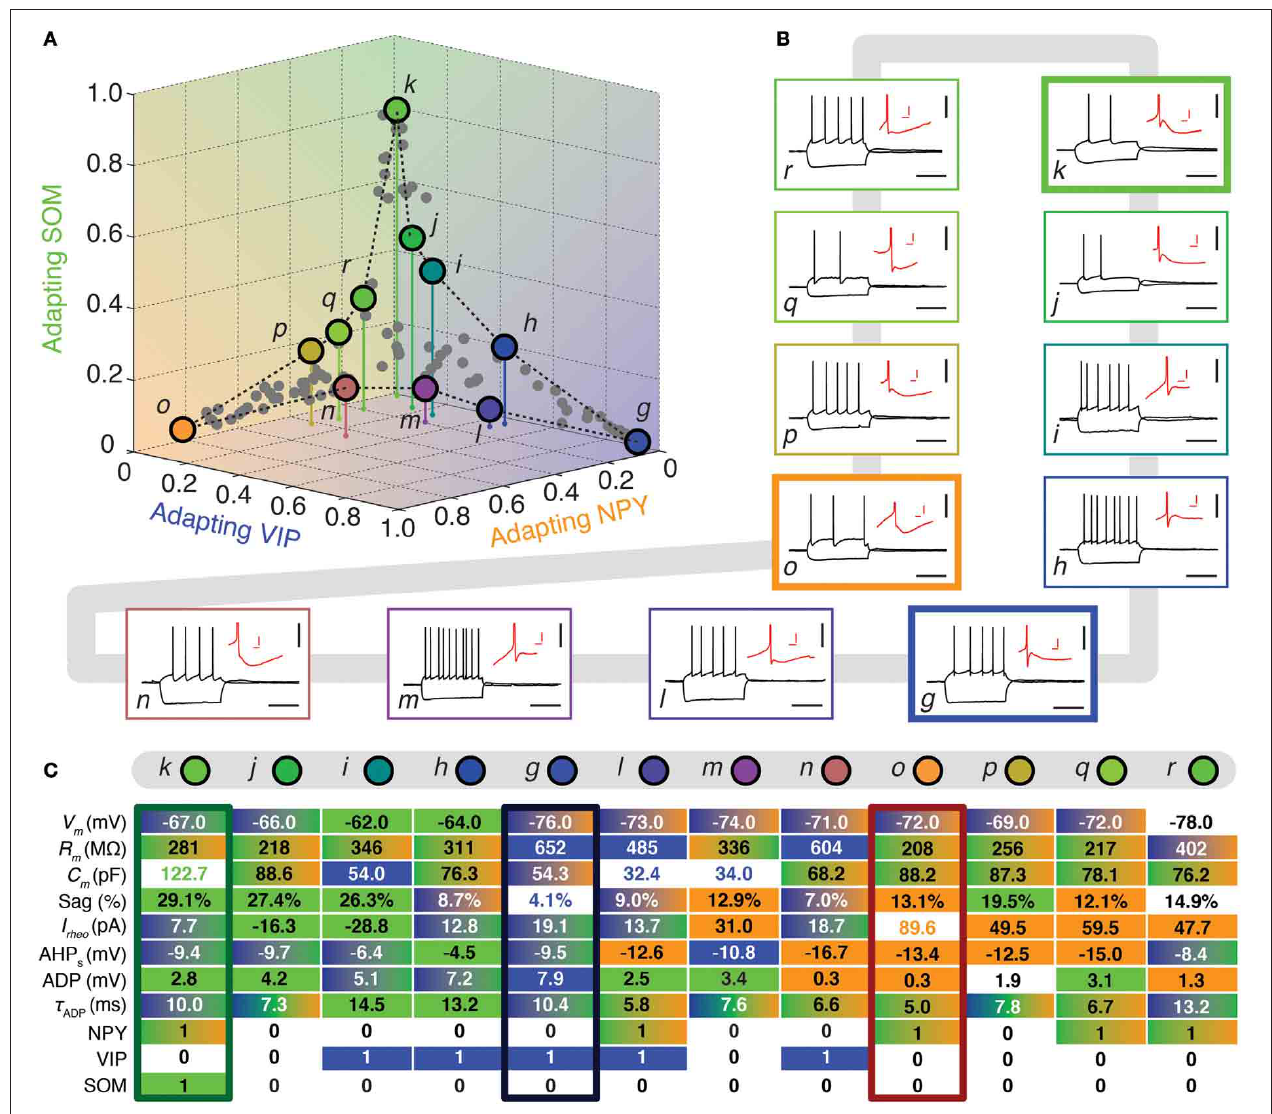
FIGURE 4 | Walking between Adapting GABAergic archetypes. (A) Tetrahedral representation linking Adapting VIP (blue), Adapting SOM (green), and Adapting NPY (orange) archetypes. Individual neurons are depicted as dots in the 3D space of memberships. The X, Y, and Z axes correspond to memberships to the Adapting VIP, Adapting NPY, and Adapting SOM archetypes, respectively. Vertical stems denoting the projection of selected cells on the bidimensional base plane are introduced as depth clues. (B) Current-clamp recordings of illustrative transition neurons (cells g to r colored in panel A ) in response to rheobase current and to a 100pA hyperpolarizing current pulse (black traces, scale bars 50mV, 400ms). Insets: details of the repolarization